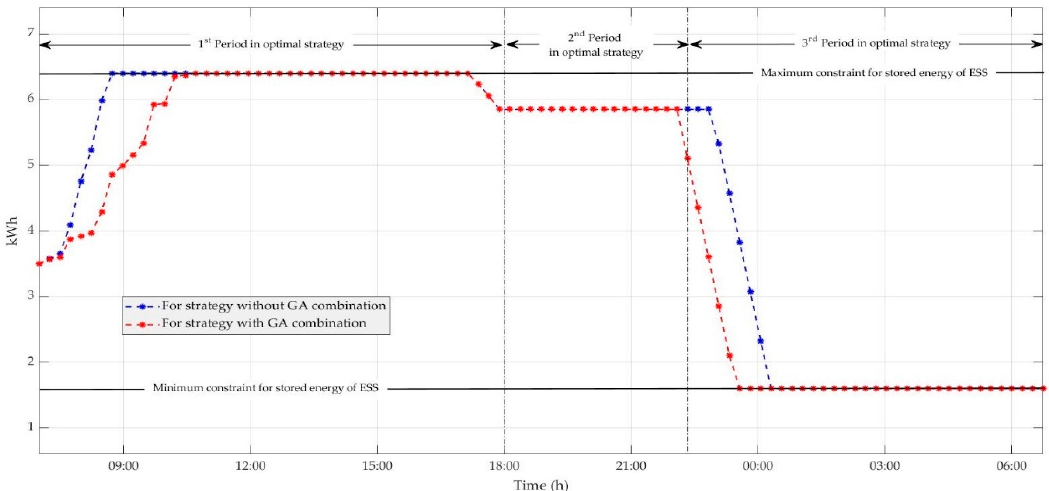
Figure 12. Comparison of stored energy of the ESS using strategies with and without the GA.